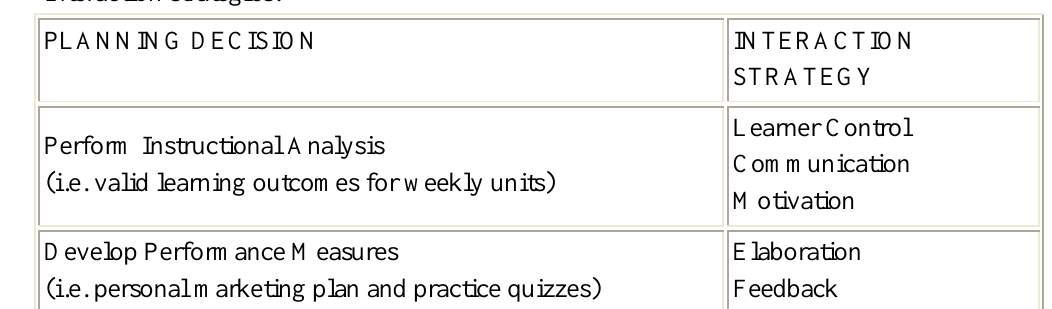
Table 1. Summary o f Planning Decisions And Interaction